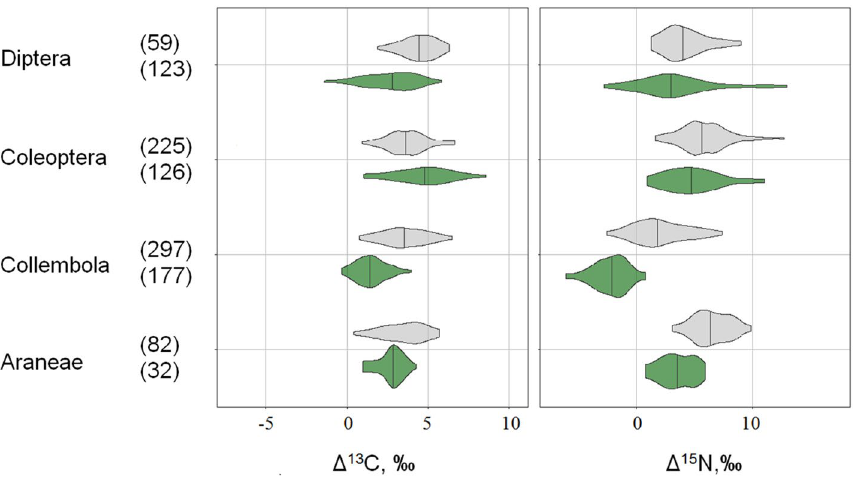
Figure 2. Stable isotope composition of arthropods from soil and litter (Potapov et al. 16 , gray) and the arthropod rain (original data, green). Litter-normalized Δ 13 C and Δ 15 N are shown as violin plots (mirrored kernel density estimation) with medians and 2.5–97.5% percentiles. Only groups represented by more than 30 data records are shown, and the number of samples is given in brackets. The difference within pairs was significant in all cases (Mann–Whitney test, P <